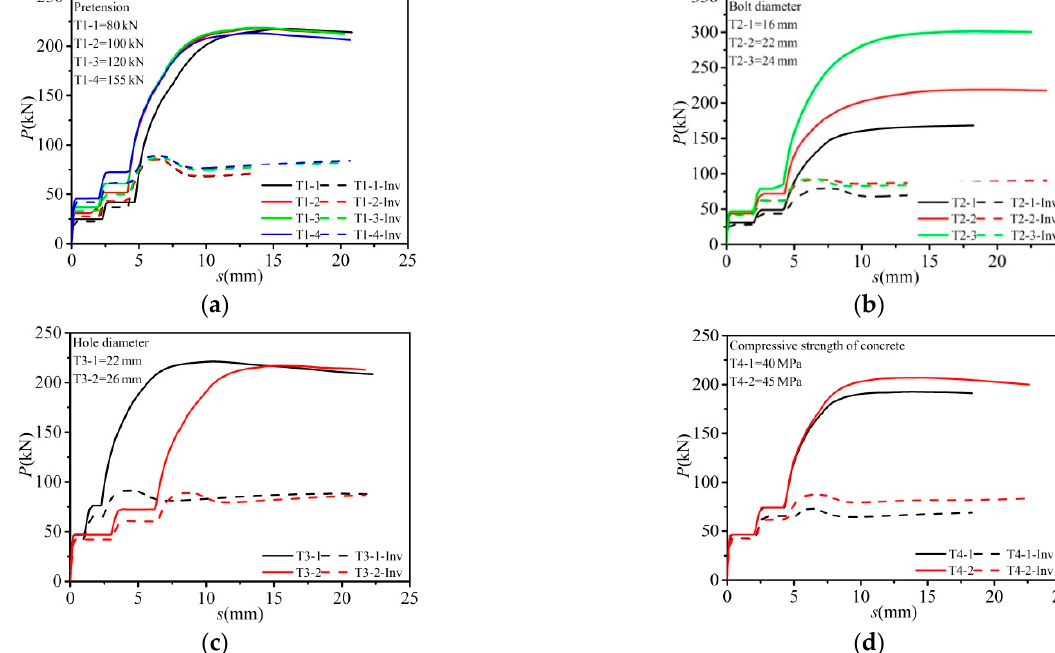
Figure 9. Comparison of load–slip curves between push-off and inverse push-off models: ( a ) T1 group; ( b ) T2 group; ( c ) T3 group; ( d ) T4 group.